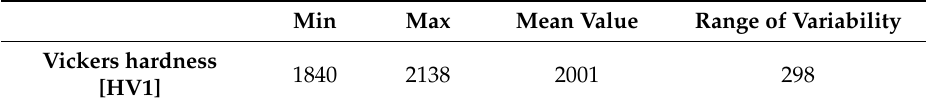
Table 5. Vickers hardness